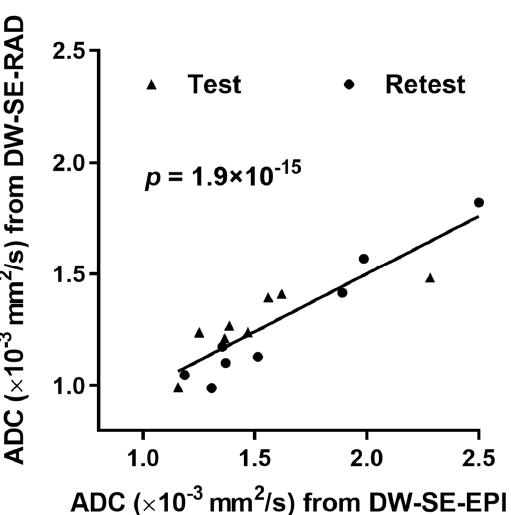
Figure 3. Correlation analysis of the tumor ADC values estimated by the DW-SE-RAD vs. DW-SE-EPI protocols using the generalized estimating equations approach. The analysis was applied to mice ( n = 8) that were subjected to both DWI protocols in both the test and retest scans (detailed in